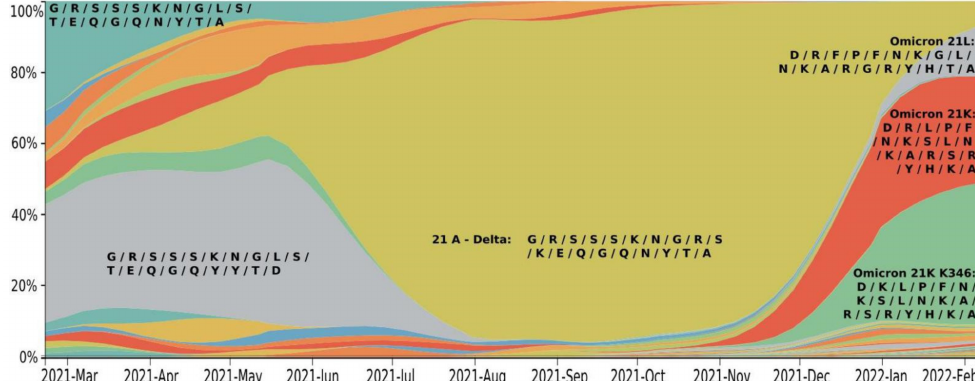
Figure 5. Time series of important mutations in the RBD of Spike. Generated by NextStrain [10,11]. Amino acid replacements in the RBD sequence at key positions (339/346/371/373/375/417/ 440/446/452/477/478/484/493/496/498/501/505/547/570) and their frequency in SARS-CoV-2 sublineages: 21A (Delta), 21K (Omicron BA.1), 21K (BA.1 + K346), 21L (Omicron BA.2) from February 2021 to February 2022. Letters indicate amino acids in the same order as the positions were listed above. Colors were allocated according to the different sets of amino acid mutations in the RBD: 21A—mustard; 21L—grey; 21K—orange red; 21K (BA.1 +